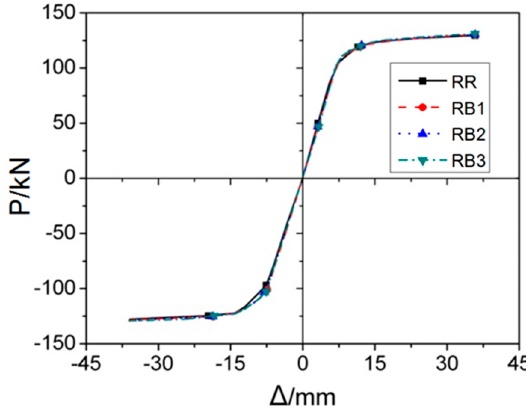
Figure 15. The skeleton curves of RB series FE models under cyclic loading.